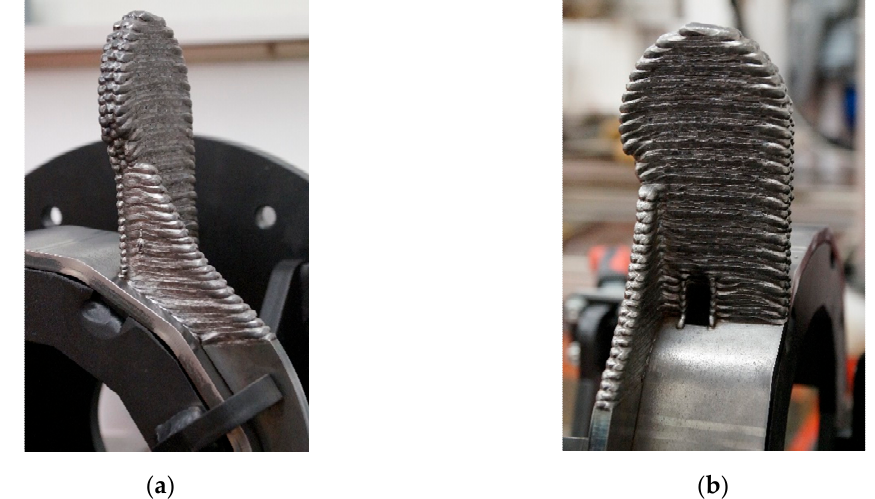
Figure 12. ( a ) Result of the first attempt for manufacturing the AM-part; ( b ) detailed view of the featured cut-out.